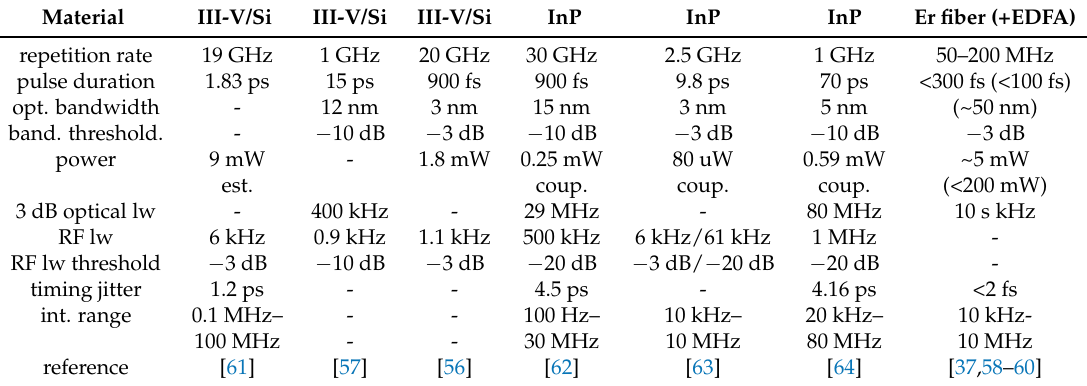
Table 2. Passively mode-locked semiconductor lasers in comparison to Erbium-doped fiber